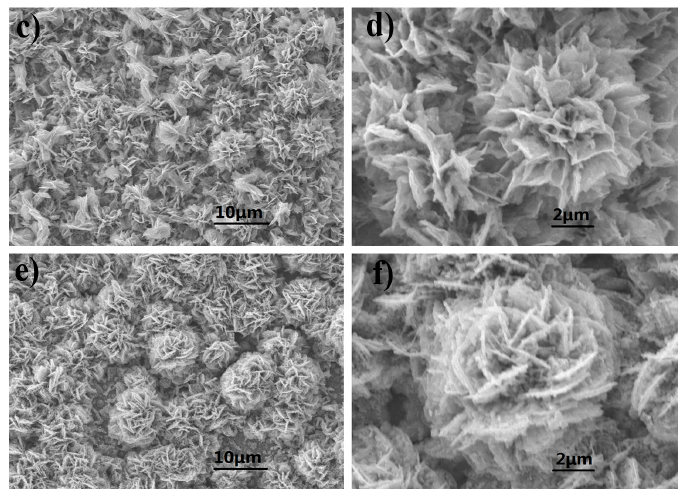
Figure 4. ( a , b ) SEM images of Cu–Co oxide; ( c , d ) SEM images of P–Cu–Co sulfide; ( e , f ) SEM images of O–Cu–Co sulfide.